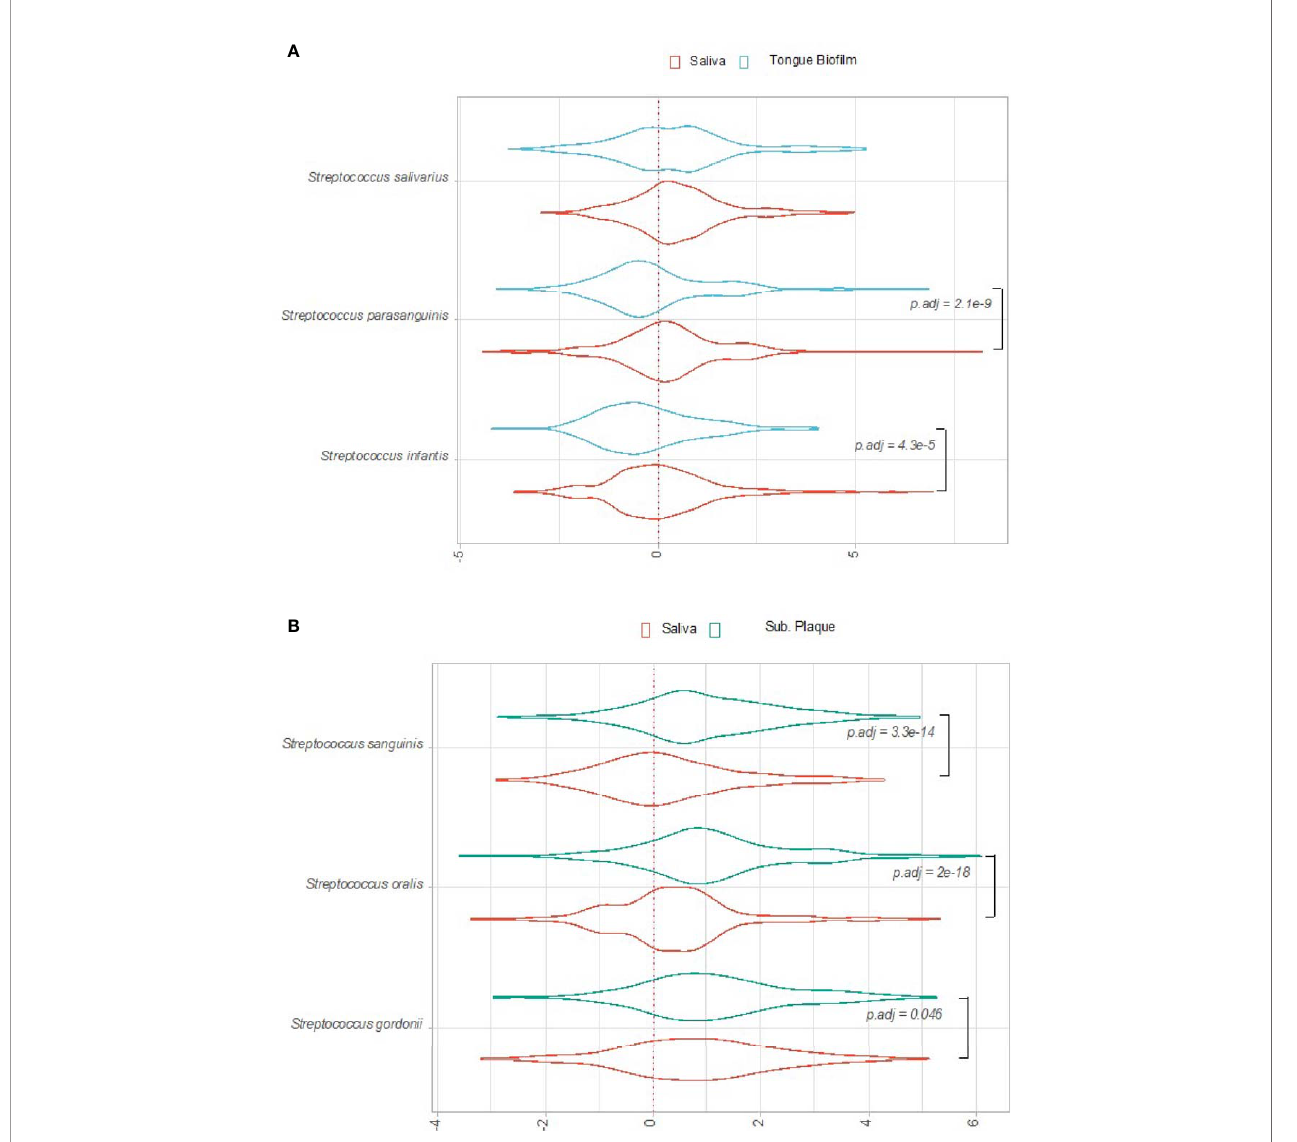
FIGURE 2 | Overall transcriptional activity of predominant Streptococcus species in oral health. Transcriptional activity of predominant Streptococcus species, as evaluated by log2(RNA/DNA) with each dot representing a speci fi c pathway. (A) Saliva versus tongue bio fi lm. (B) Saliva versus subgingival plaque. Color coding: red: saliva, blue: tongue bio fi lm, green: subgingival